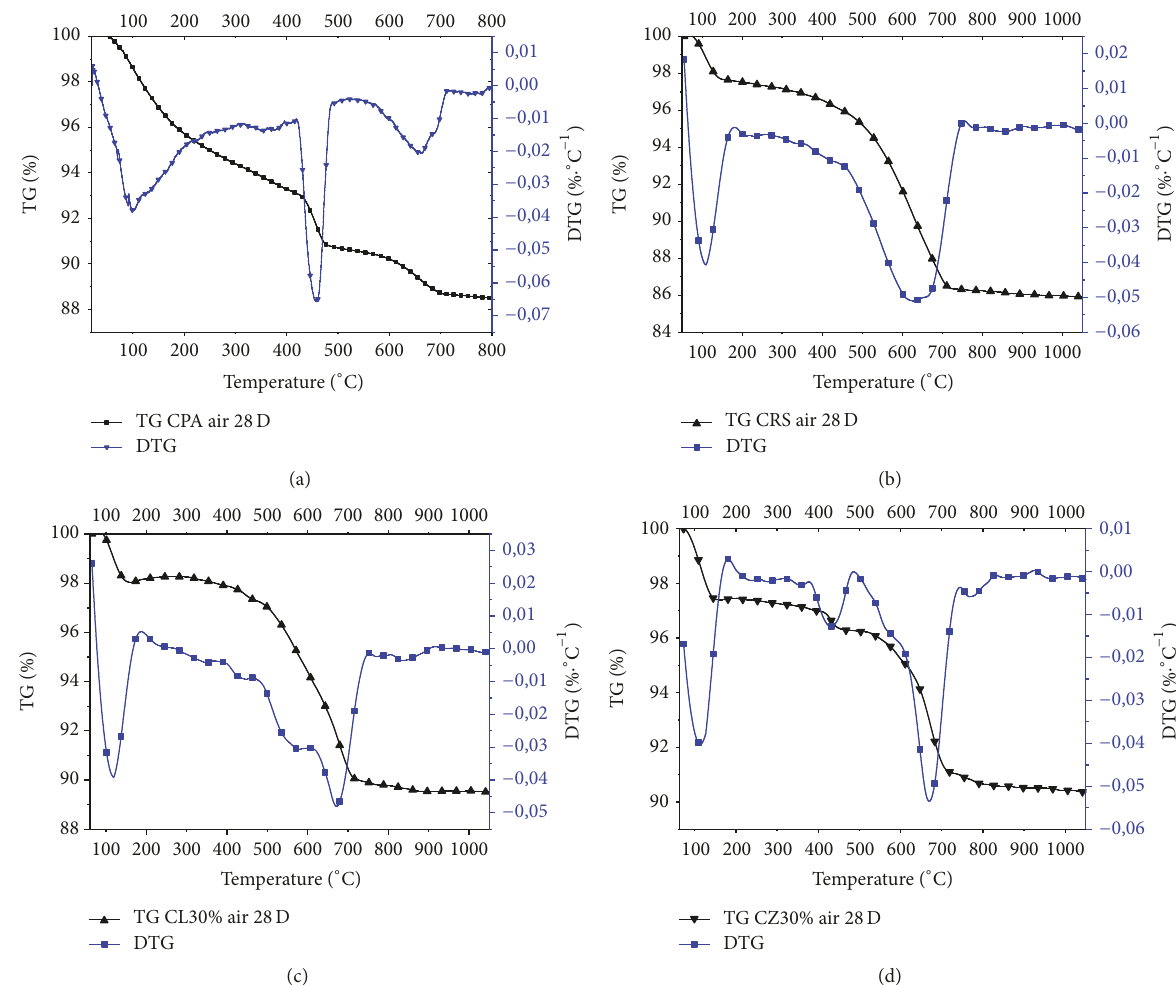
Figure 6: DTG/TG cement paste preserved on air (RH = 65%, 𝑇 = 20 ∘ C) for 28 days; (a) CPA, (b) CRS, (c) CL30% (30% slag), and (d) CZ3% (30%